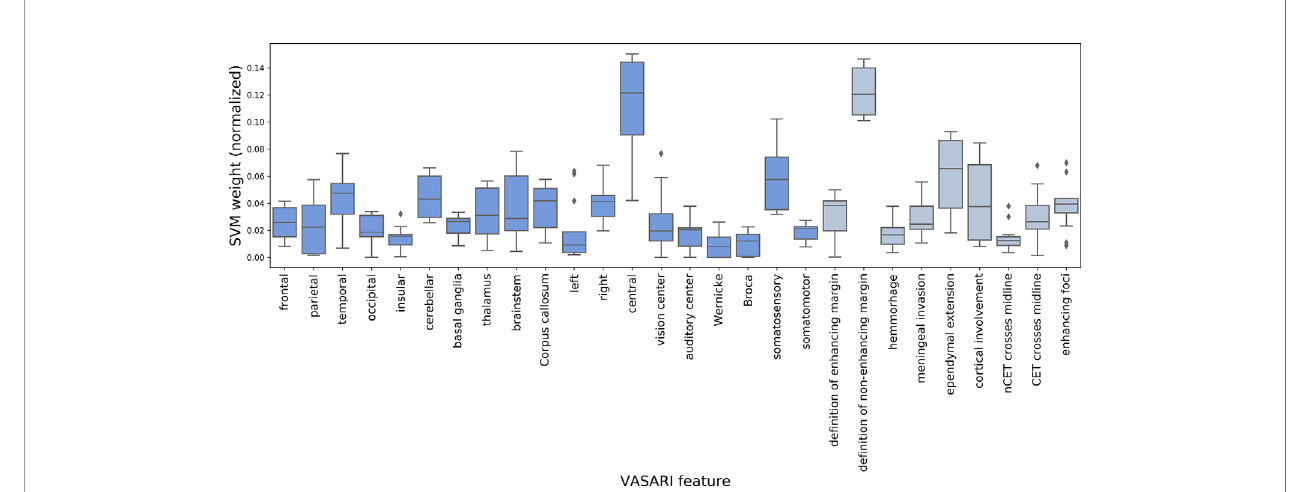
FIGURE 8 | Result for repeated fi tting of linear soft-margin Support Vector Machine (SVM) for a total of 12 different hyperparameter con fi gurations. Higher median SVM weights across different hyperparameter con fi gurations indicate VASARI feature which are more important for differentiation of BMs from GBMs (dark blue = localization-based features, gray = appearance-based features).